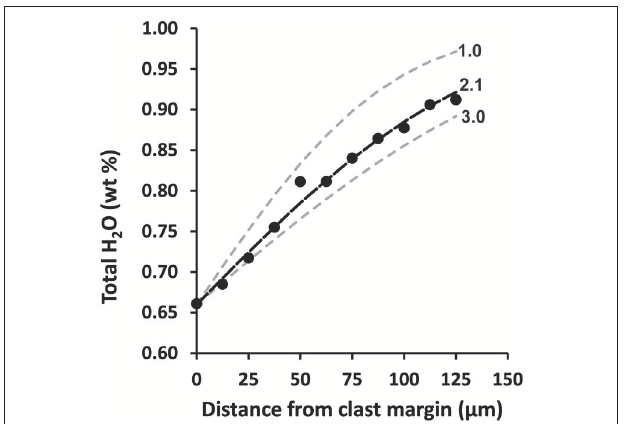
FIGURE 8 | Measured spatial variation in H 2 O at vesicular clast margin (from Figure 5B traverse), with best fit 1D diffusion model (2.1 h) and model results for 1 and 3h for comparison. See text for description of model